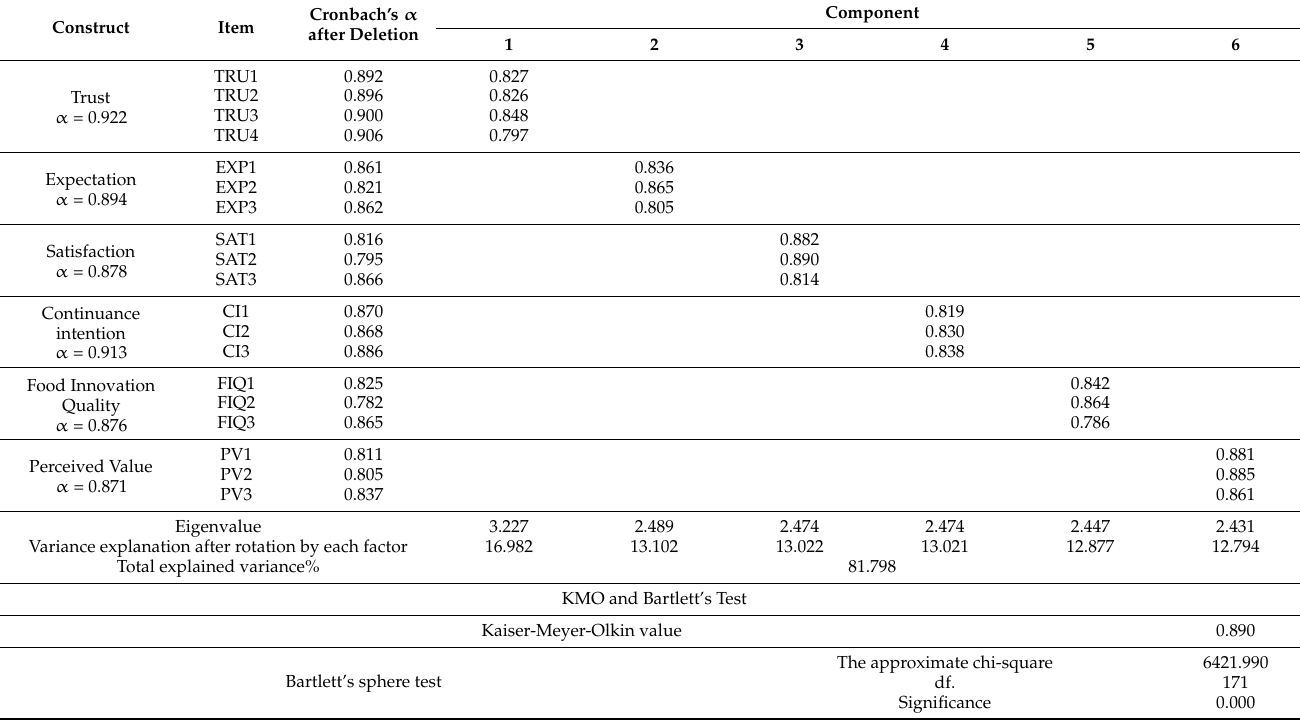
Table 3. The reliability and exploratory factor